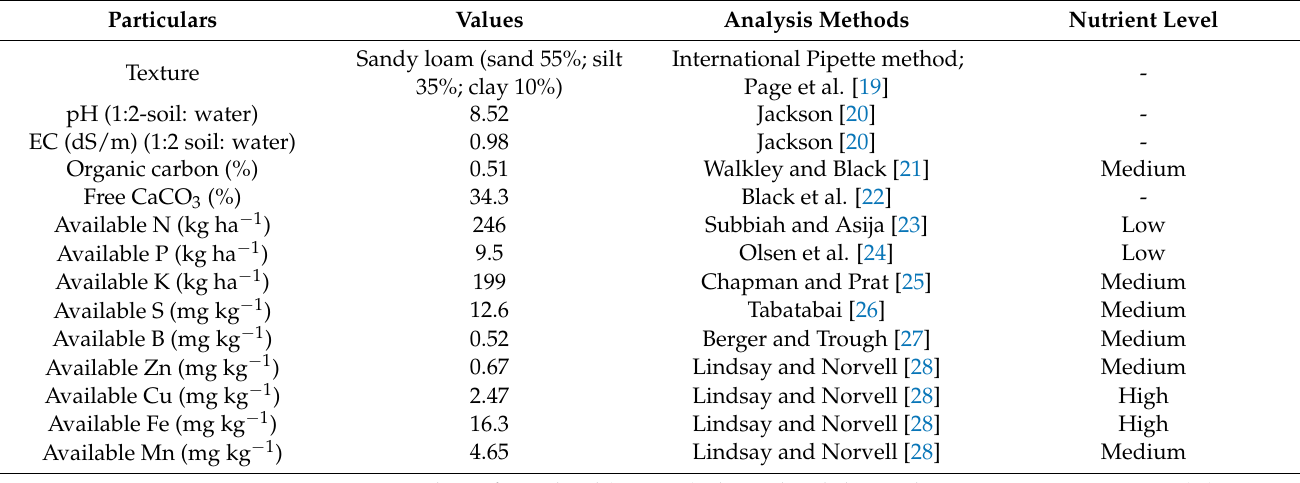
Table 1. Initial soil (0–15 cm) physical and chemical properties of the experimental